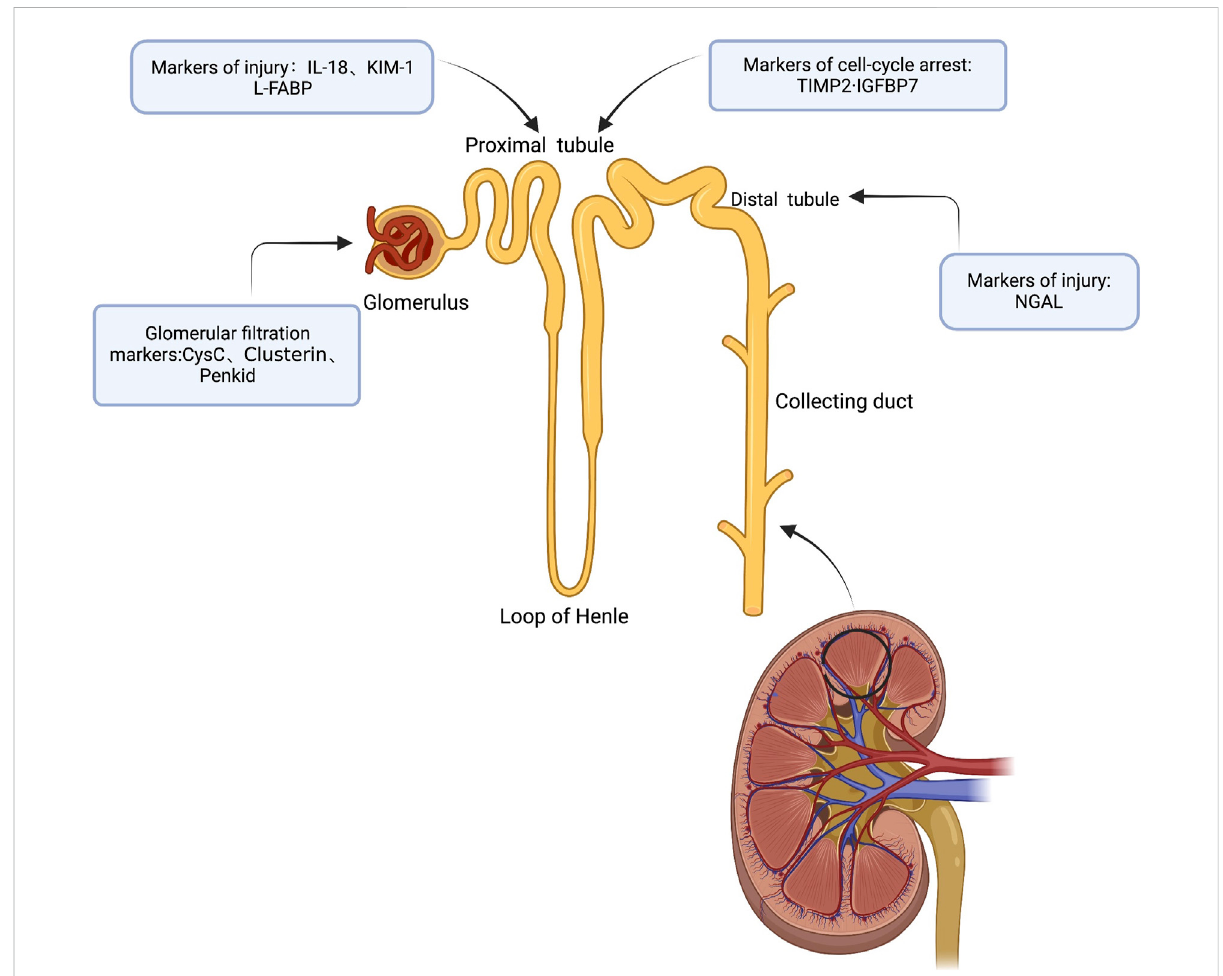
FIGURE 1 Subclinical AKI biomarkers are labeled according to anatomic location and/or production mechanism (Created with